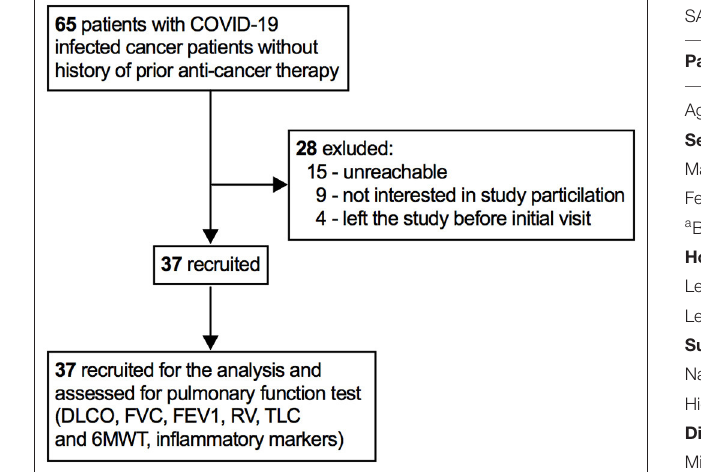
FIGURE 1 | Patients recruitment profile. DLCO, lung diffusion for carbon monoxide; FVC, forced vital capacity; FEV1, forced expiratory volume in 1 second; RV, residual volume; TLC, total lung capacity; 6MWT, 6-minute walking time.